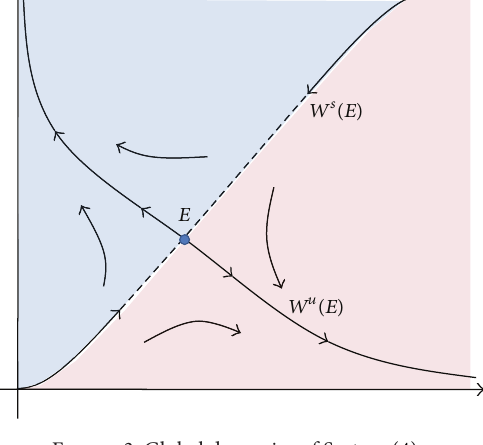
Figure 3: Global dynamics of System